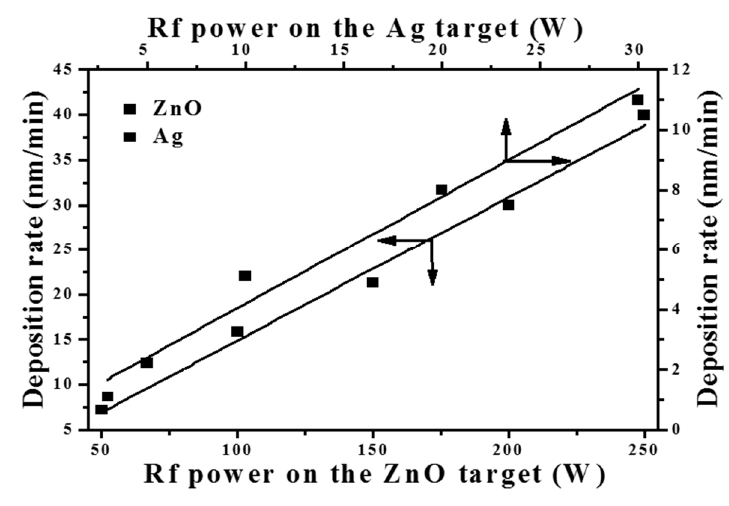
Figure 1. Deposition rates of the single ZnO and Ag films as functions of the RF power supplied on the ZnO and Ag targets, respectively.